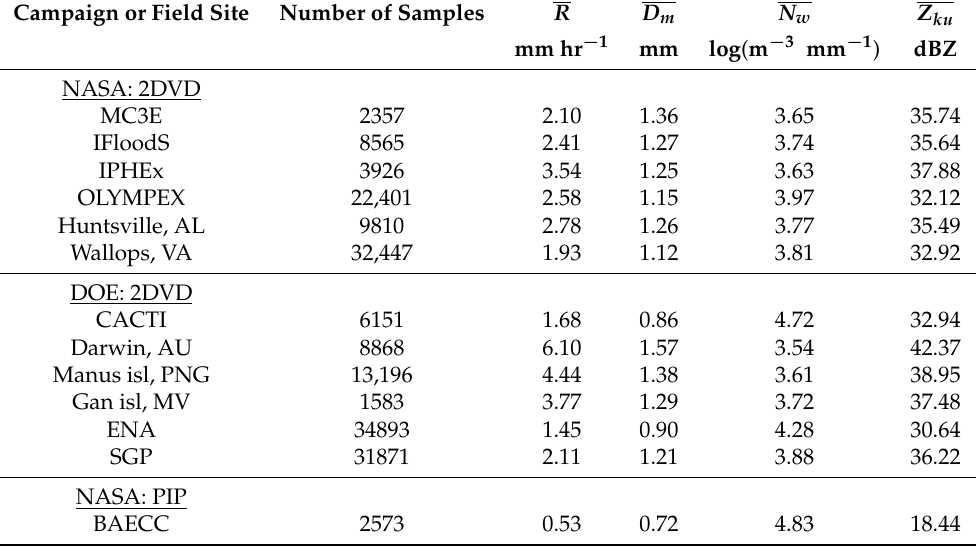
Table 1. Statistics of disdrometer measurements. The equations to calculate the parameters below are found in the following section, and their means (when R ≥ 0.01 mm hr − 1 ) are reported in the table. The number of samples refers to the number of 5 min particle size distributions (PSDs). The means of N w and Z ku were calculated in linear units and then converted to the logarithmic units shown. The underlined text in the first column denotes the data source and